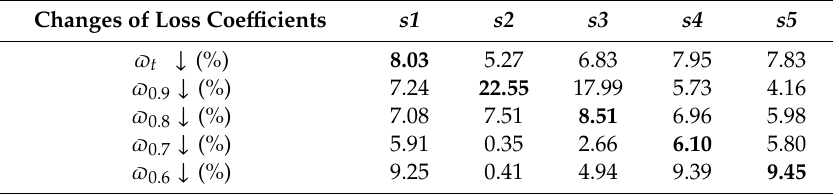
Table 5. Optimization results of the relative reduction values for different loss coefficients under different optimization schemes compared with the axisymmetric shroud stator (CFD results).